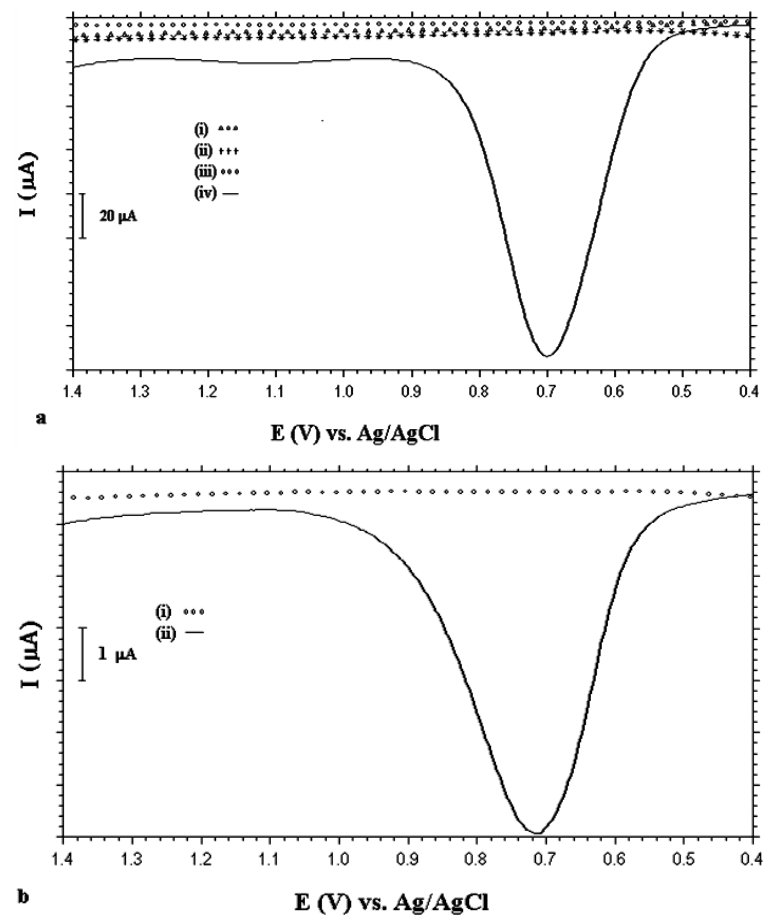
Figure 11. DPVs of ( a ) (i) PANI deposited Au electrode (ii) dsDNA immobilized PANI deposited electrode (iii) UME-2 (iv) dsDNA immobilized UME-2 ( b ) (i) ssDNA immobilized PANI deposited electrode (ii) ssDNA immobilized UME-2 in 50 mM PBS. DPV measurement: at pulse amplitude of 50 mV between +0.4 and 1.4